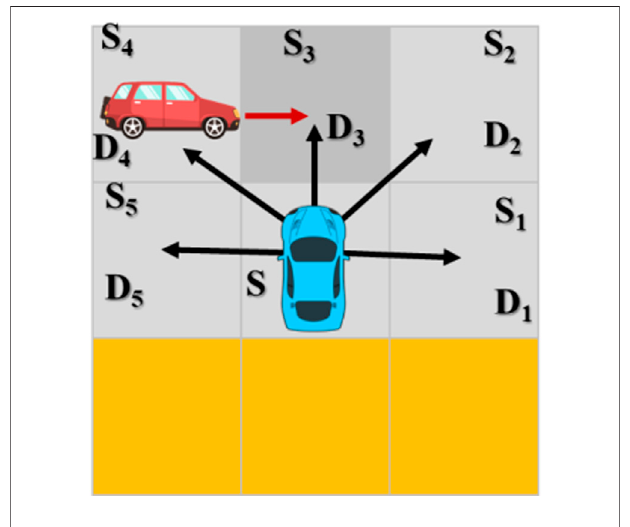
FIGURE 21 | Example of trajectory